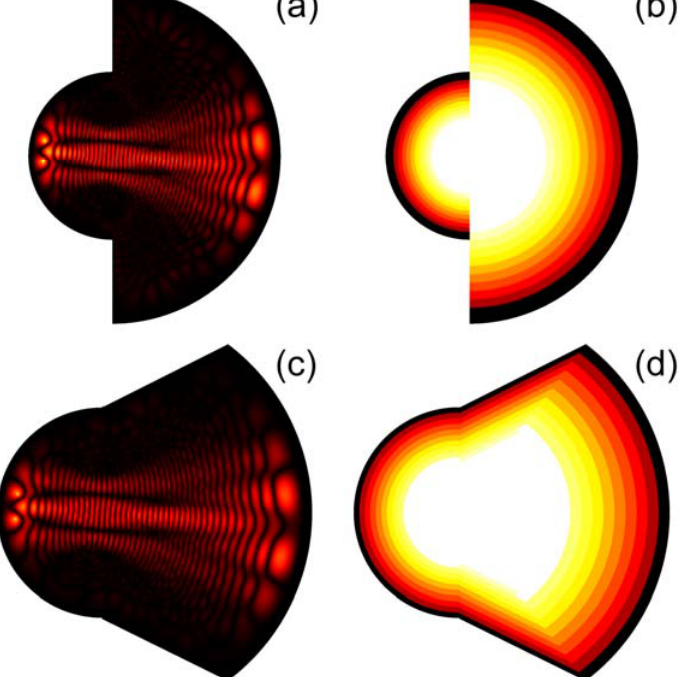
Figure 11. Numerical simulations of image magnification (M = 2) using the inverted Eaton lens. Since the sides of the lens play no role in imaging, the overall shape of the imaging device can be altered to achieve the shape of a “deformed